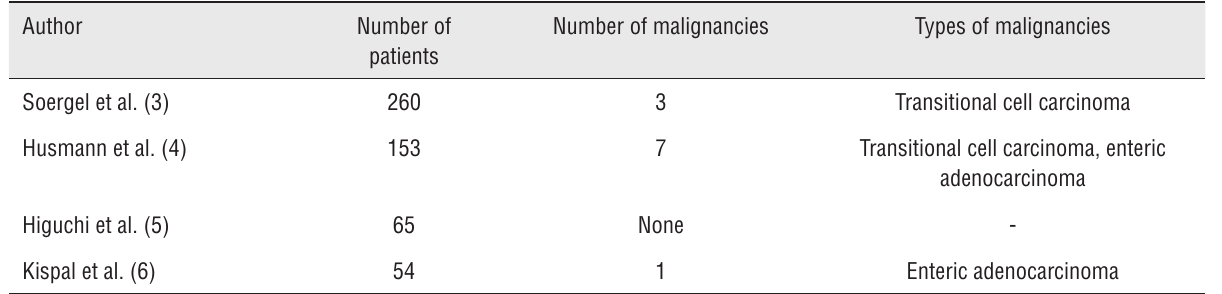
Table-2 - published routine cystoscopic surveillance series. Author Number of Number of malignancies Types of malignancies patients Soergel et al. (3) 260 3 Transitional cell carcinoma Husmann et al. (4) Transitional cell carcinoma,